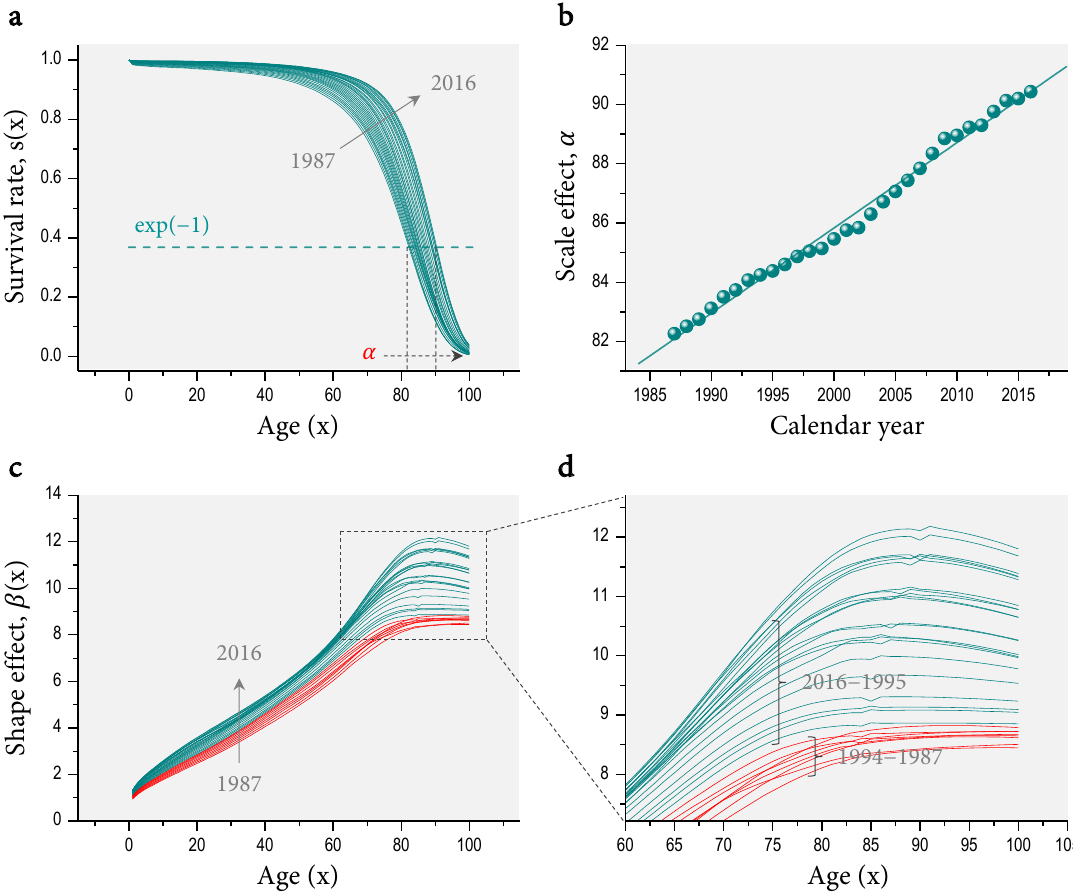
Figure 1. Survival analysis. ( a ) The survival curves for Korean female in recent decades, 1987–2016, were obtained at the complete life tables taken from the Korean Statistical Information Service (http://kosis.kr/eng). ( b ) The characteristic life of the given survival curve. ( c ) The age-dependent stretched exponent. ( d ) The old-age patterns of the stretched exponent at ages over 60 years could be fitted with the quadratic formula of age. The phase transition in the stretched exponent with age appears for 1995–2016 but not for